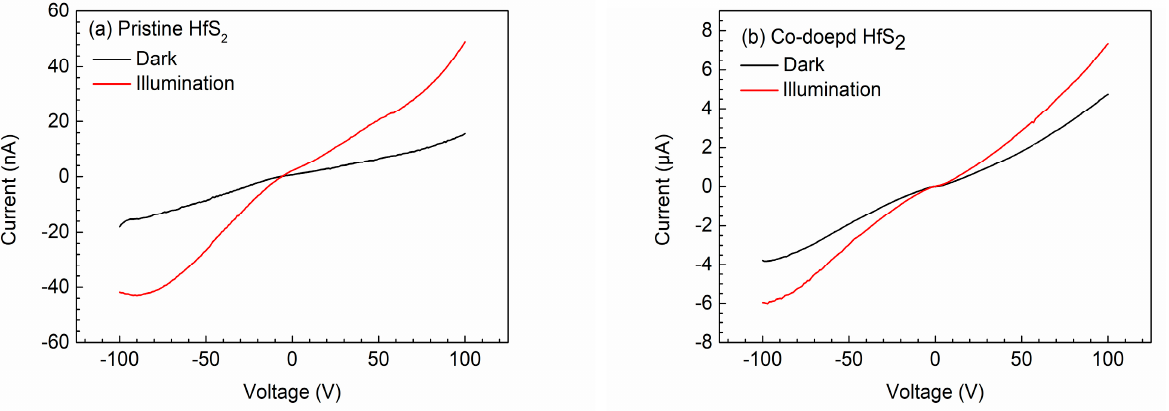
Figure 5. Current-voltage curves of ( a ) the pristine and ( b ) the Co-doped HfS 2 crystals. Table 3. The resistivity of the pristine, Mn-, Fe-, Co-, and Cu-doped HfS 2 crystals.